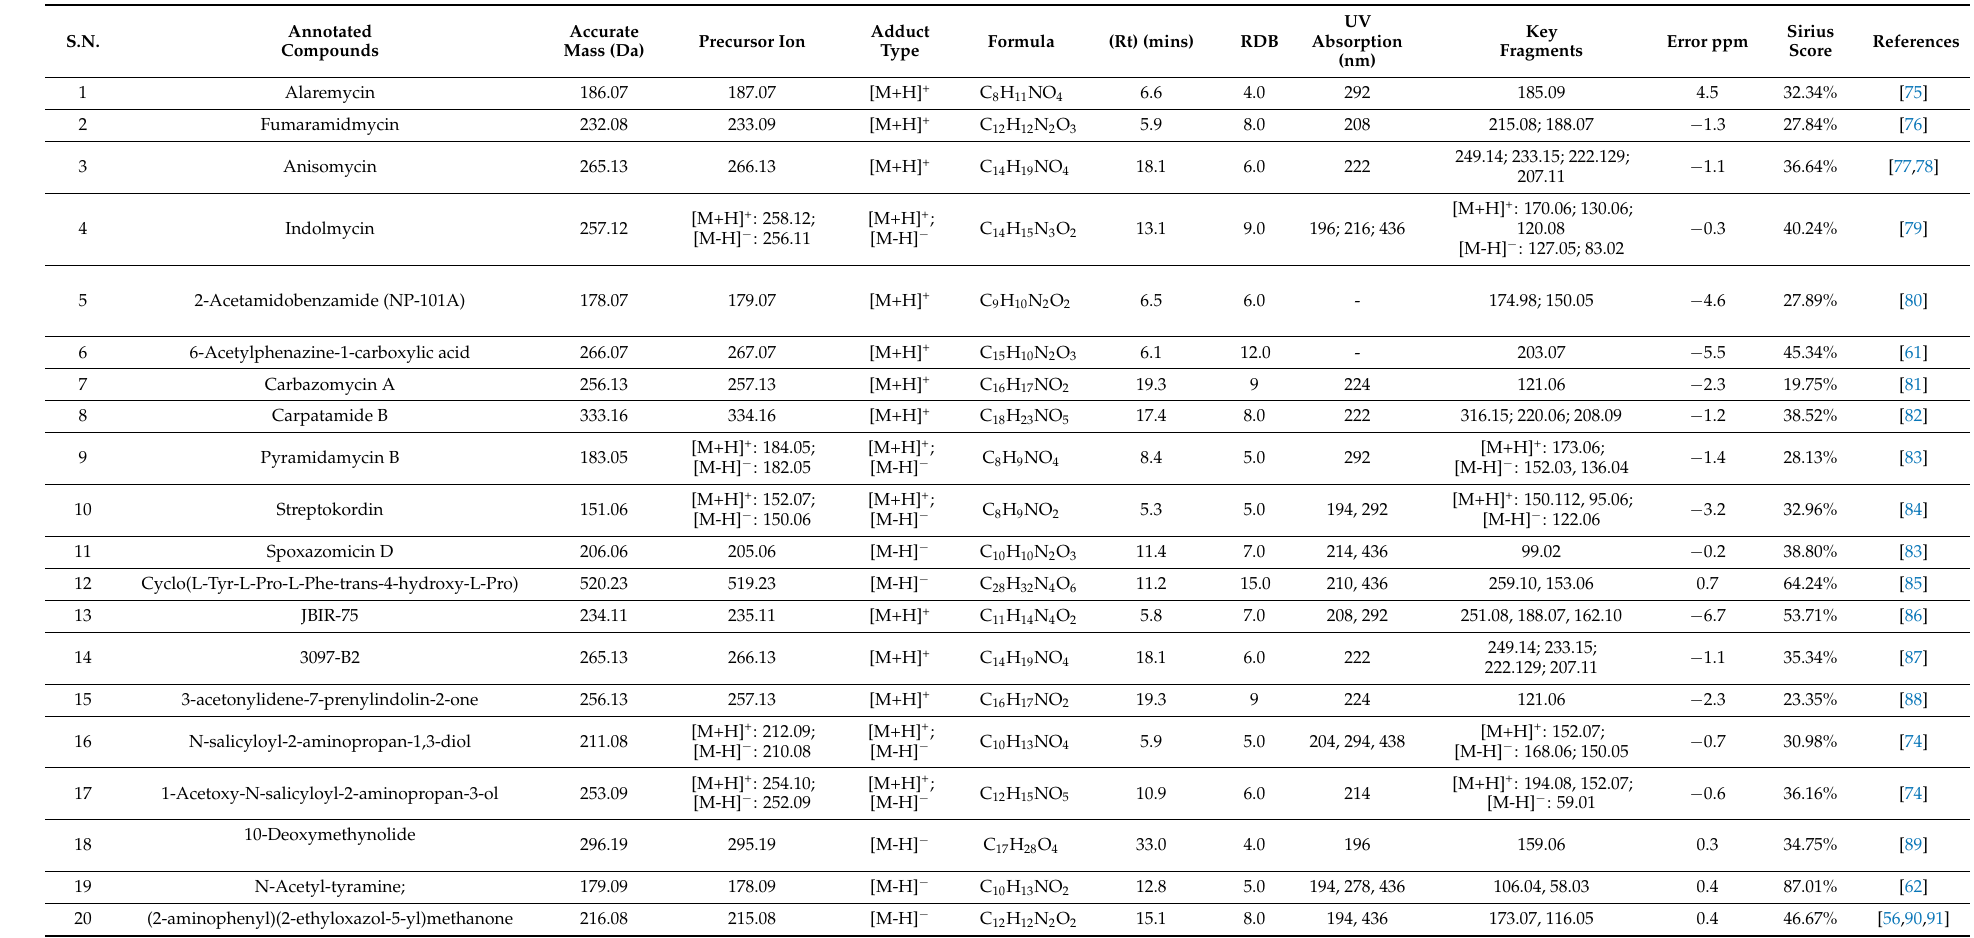
Table 2. A list of annotated compounds using SIRIUS in Streptomyces